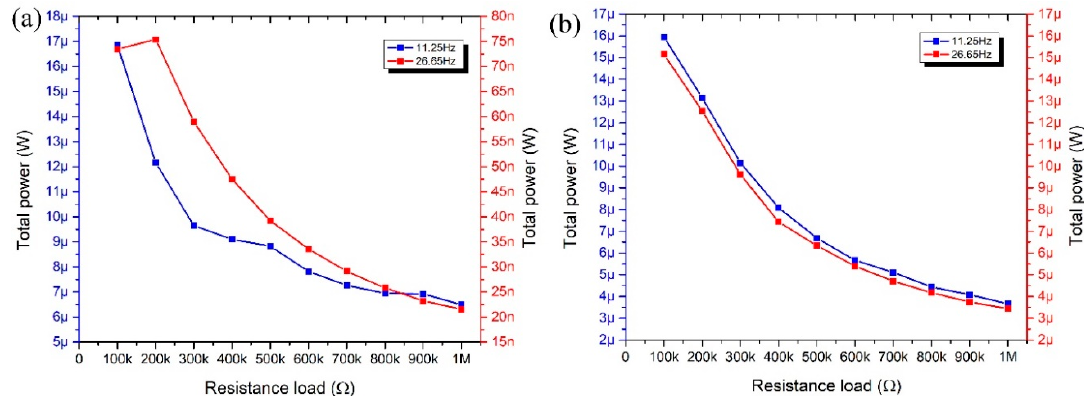
Figure 17. Measured electrical output power of bidirectional energy harvester when excitation direction is aligned with y axis ( a ) and z axis ( b ).